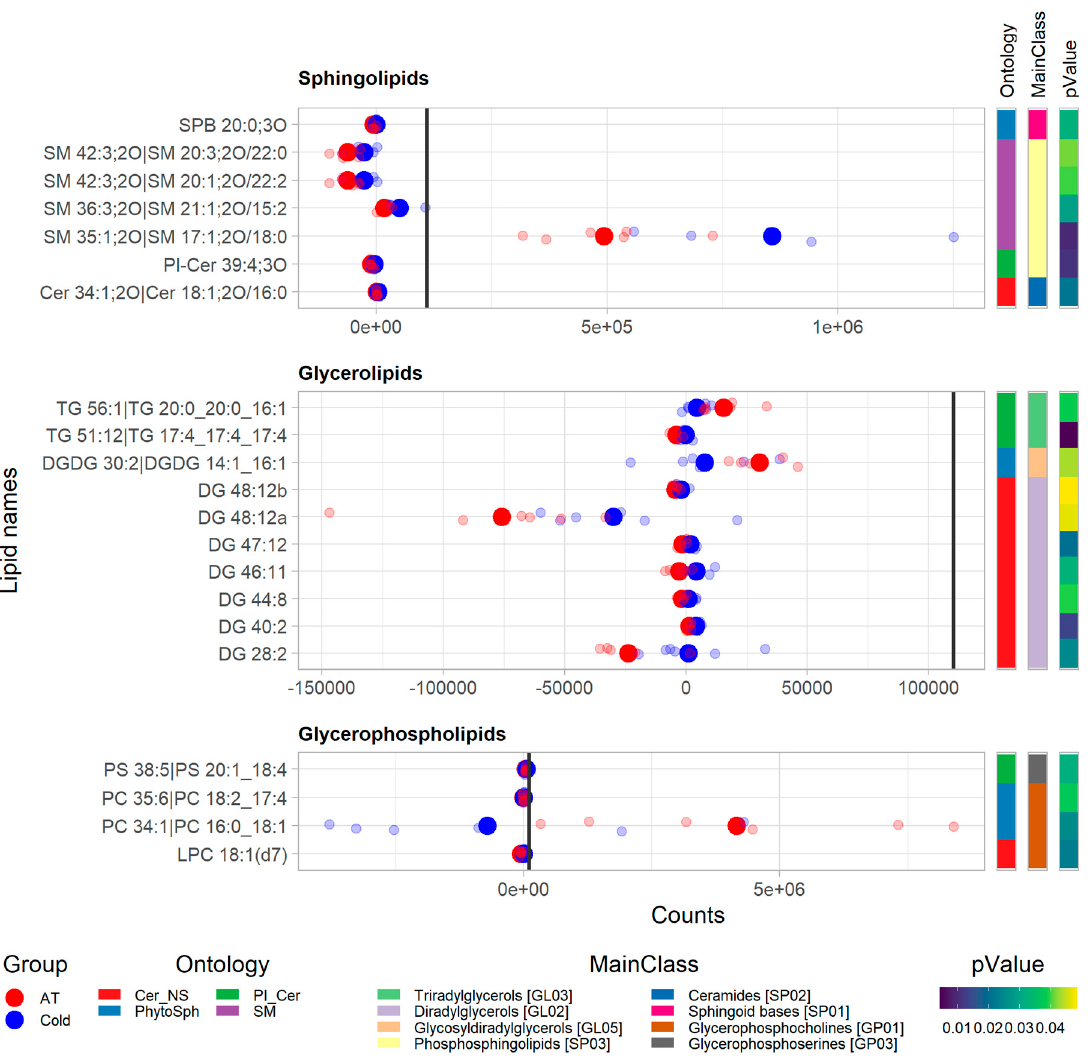
Figure 5. Plots of significantly different ( p < 0.05) lipid classes within lipid categories in plasma samples from new-born lambs kept at ambient temperature (20–22 °C, AT in red) vs. those kept at cold temperature (4 °C, cold in blue), after 1 day of exposure. Each row of dots represents a lipid metabolite with respect to its ion counts obtained from LC-MS analysis, where the big dots represent the mean and smaller dots represent individual values ( n = 6 in each group). The vertical bold black line represents the average count value across all plasma datasets, after 1 day of exposure.